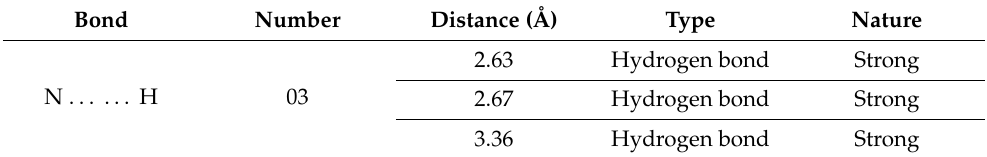
Table 4. Conformational study in the system IPN (cellulose–polyHEMA network)/malachite green dye. Bond